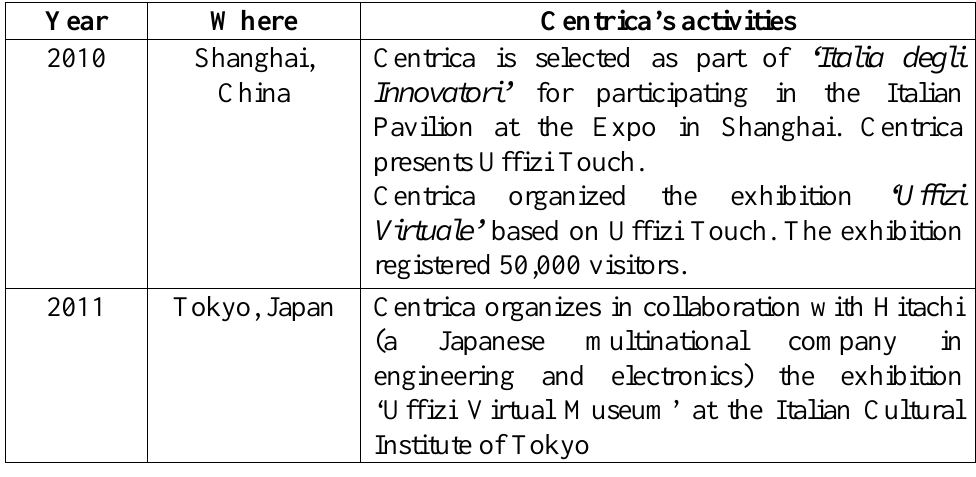
Table 1: Summary of Centrica’s International Activities (a